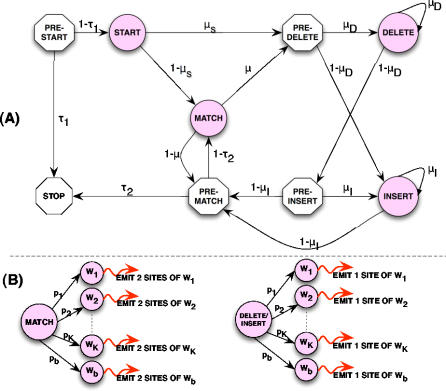
Hidden Markov Model Structure of the MORPH Model(A): Transition probabilities among various states. Circular states have emissions, and octagonal states do not.(B) Motif emissions from Match, Insert, and Delete states. For each, one of K motif states, or the background motif state is visited. In case of the Match state, two aligned sites are emitted, whereas for the Insert and Delete states, only one unaligned site is emitted.